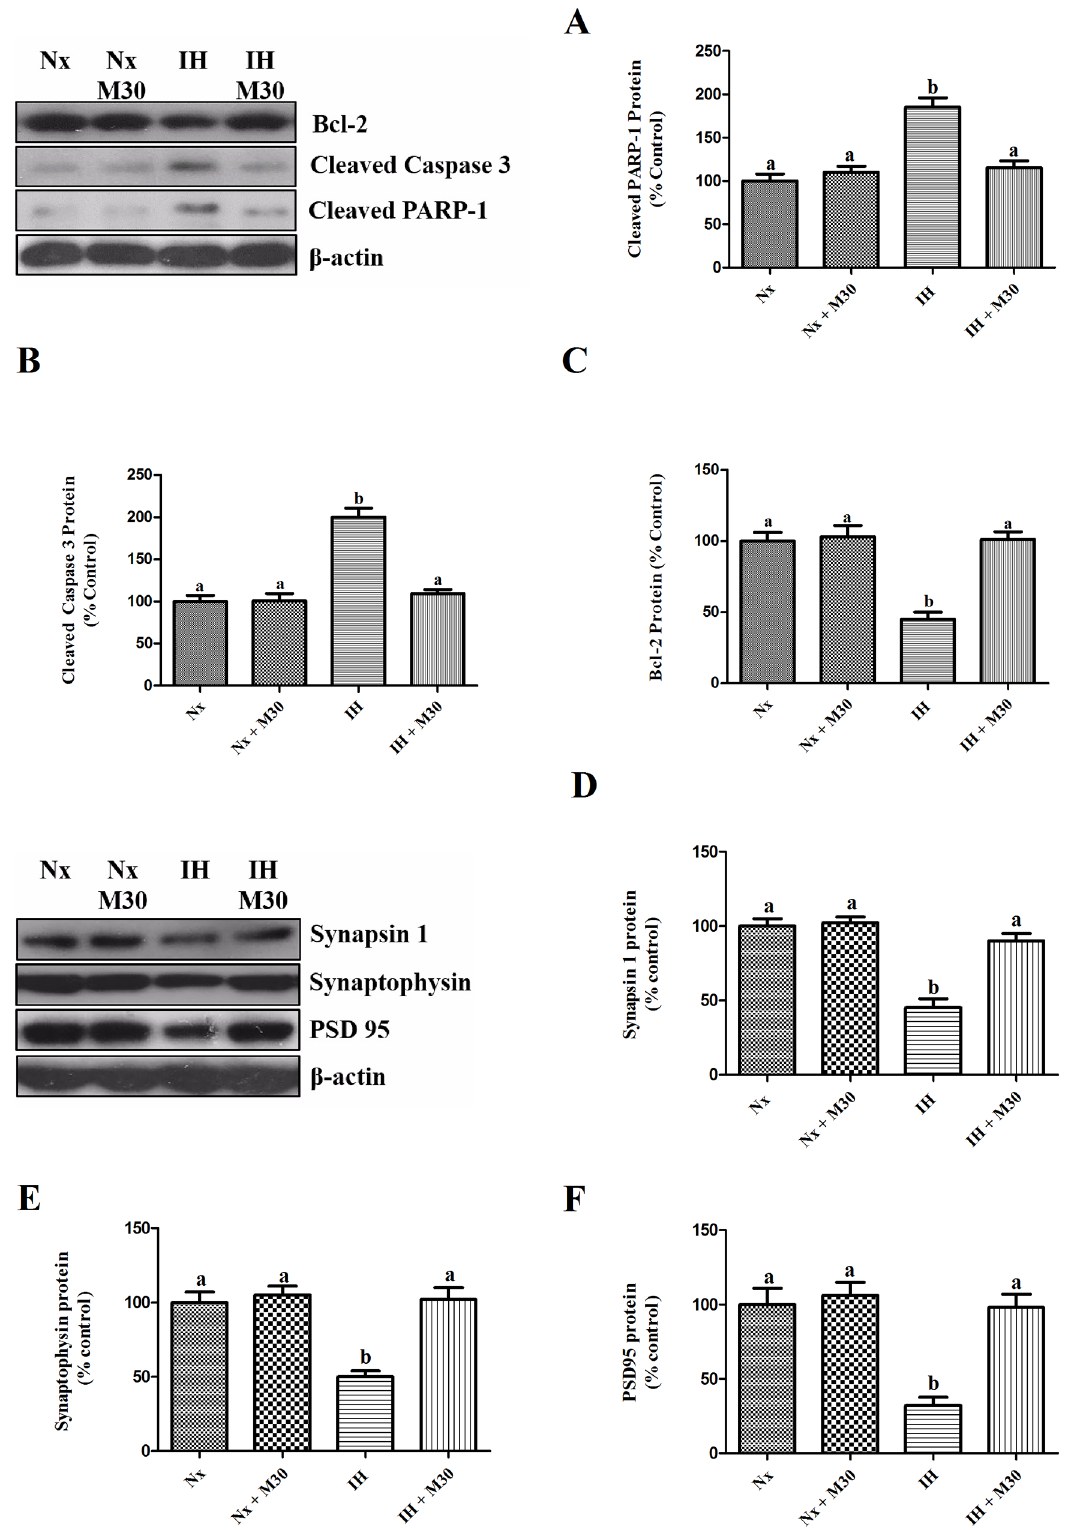
Fig 7. Hypoxia induced neuronal apoptosis and losses of pre-synaptic vesicle proteins and post-synaptic. Levels of protein expressionof (A) Bcl-2, (B) CleavedCaspase 3, (C) CleavedPARP-1, (D) Synapsin-1, (E) Synaptophysin and